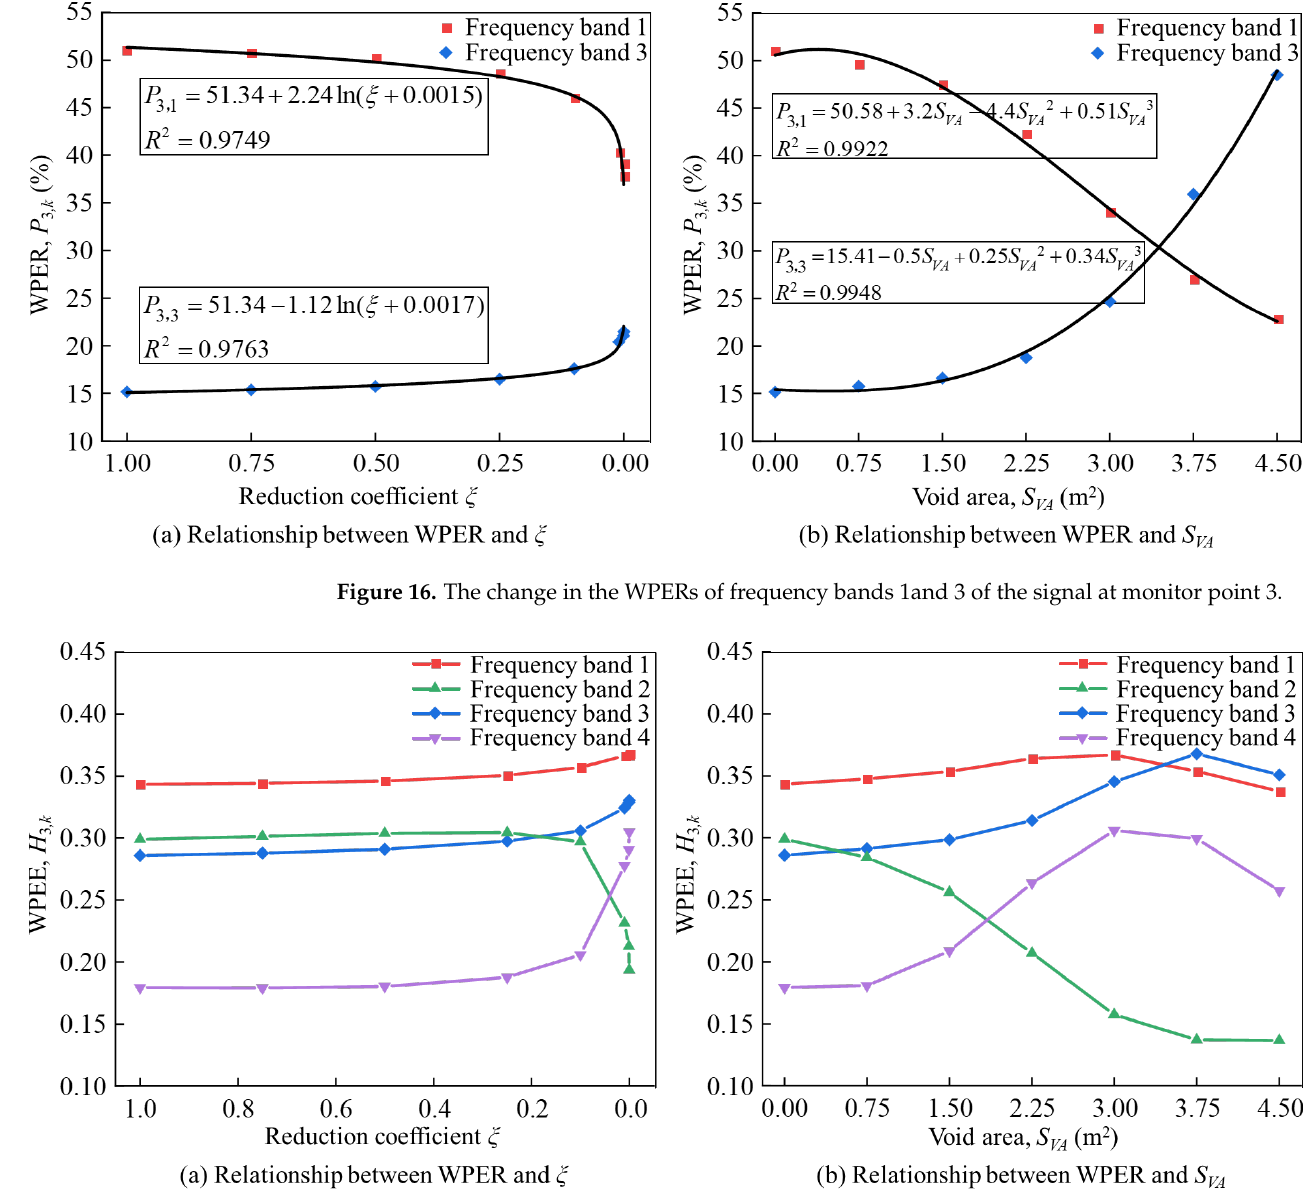
Figure 16. The change in the WPERs of frequency bands 1and 3 of the signal at monitor point 3.